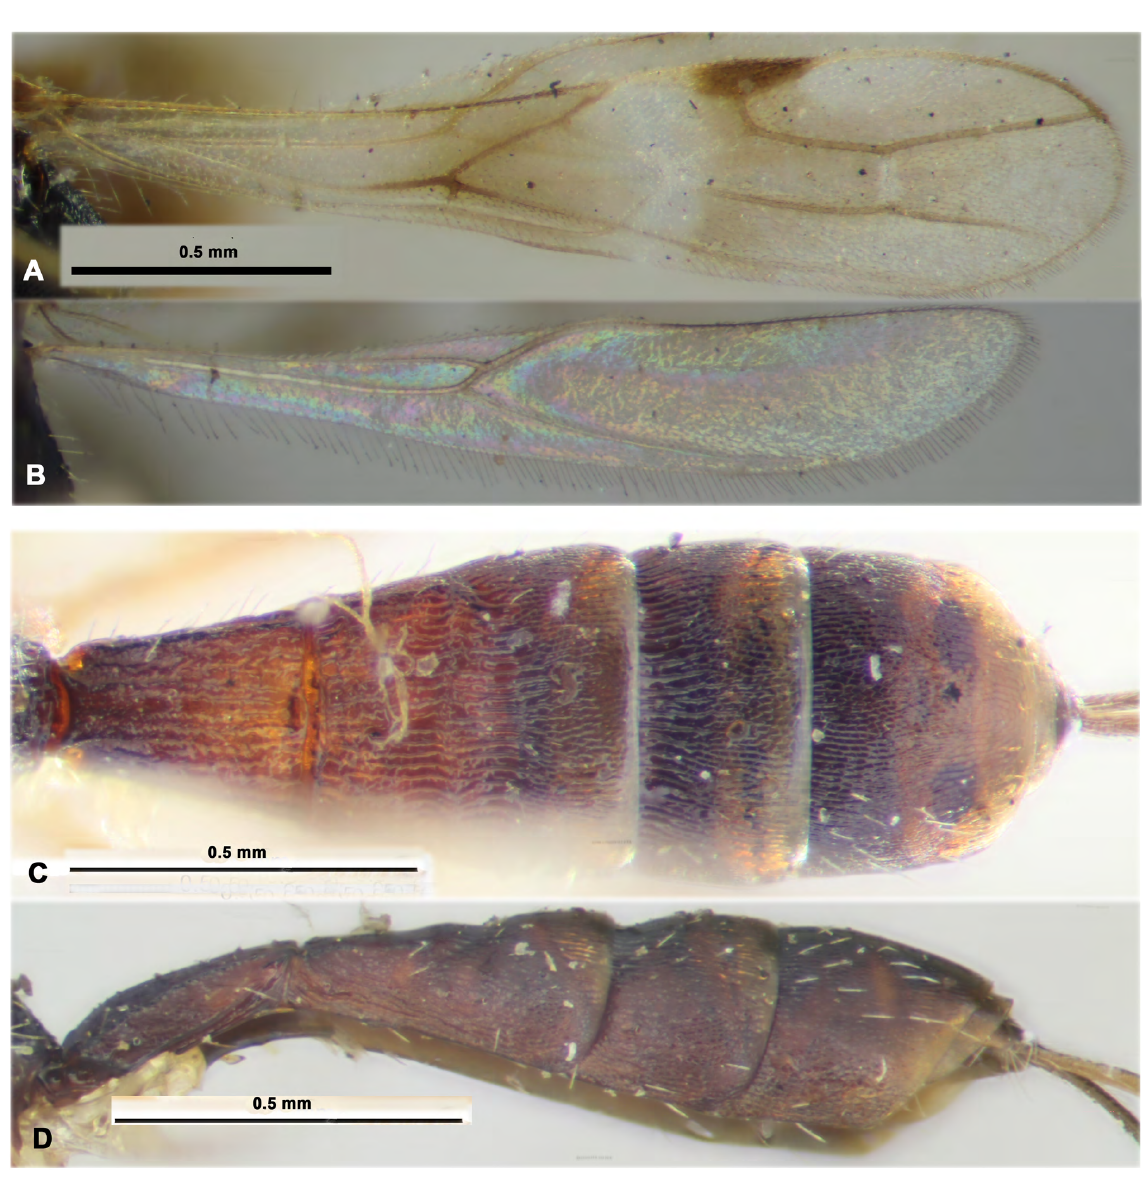
Fig. 45. Rhaconotus ( Rhaconotus ) aciculatus Ruthe, 1854, ♀, holotype, BMNH. A . Fore wing. B . Hind wing. C . Metasoma, dorsal view. D . Metasoma, lateral